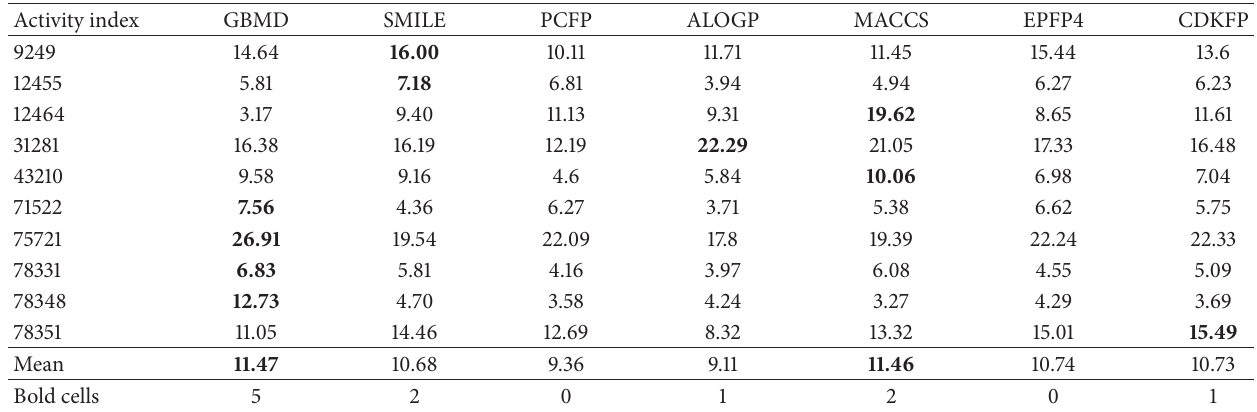
Table 8: Retrieval results of top 1% for data set